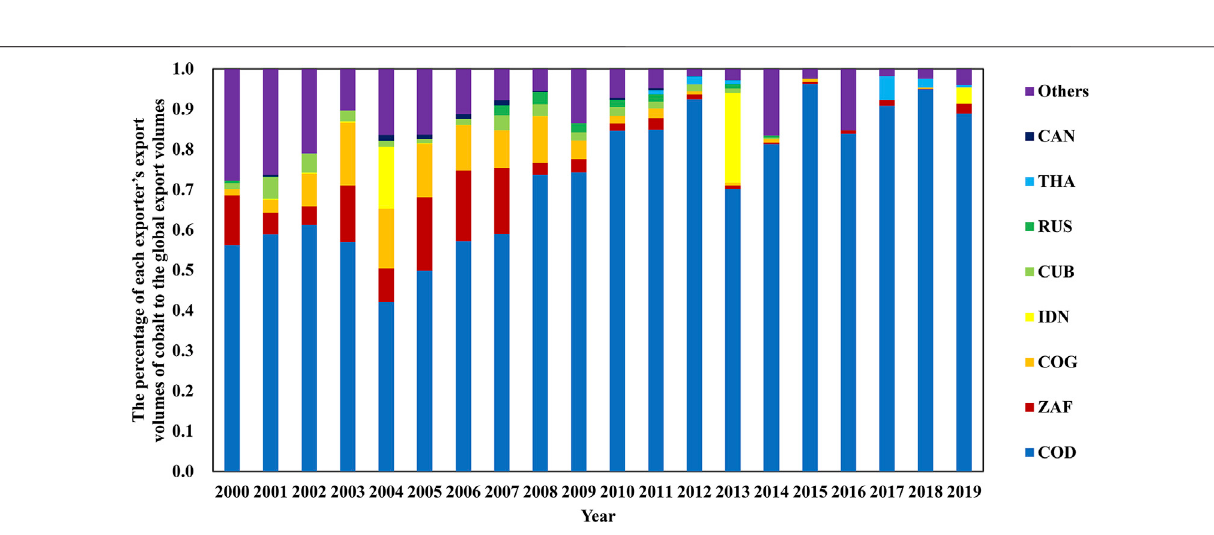
Frontiers in Energy Research |